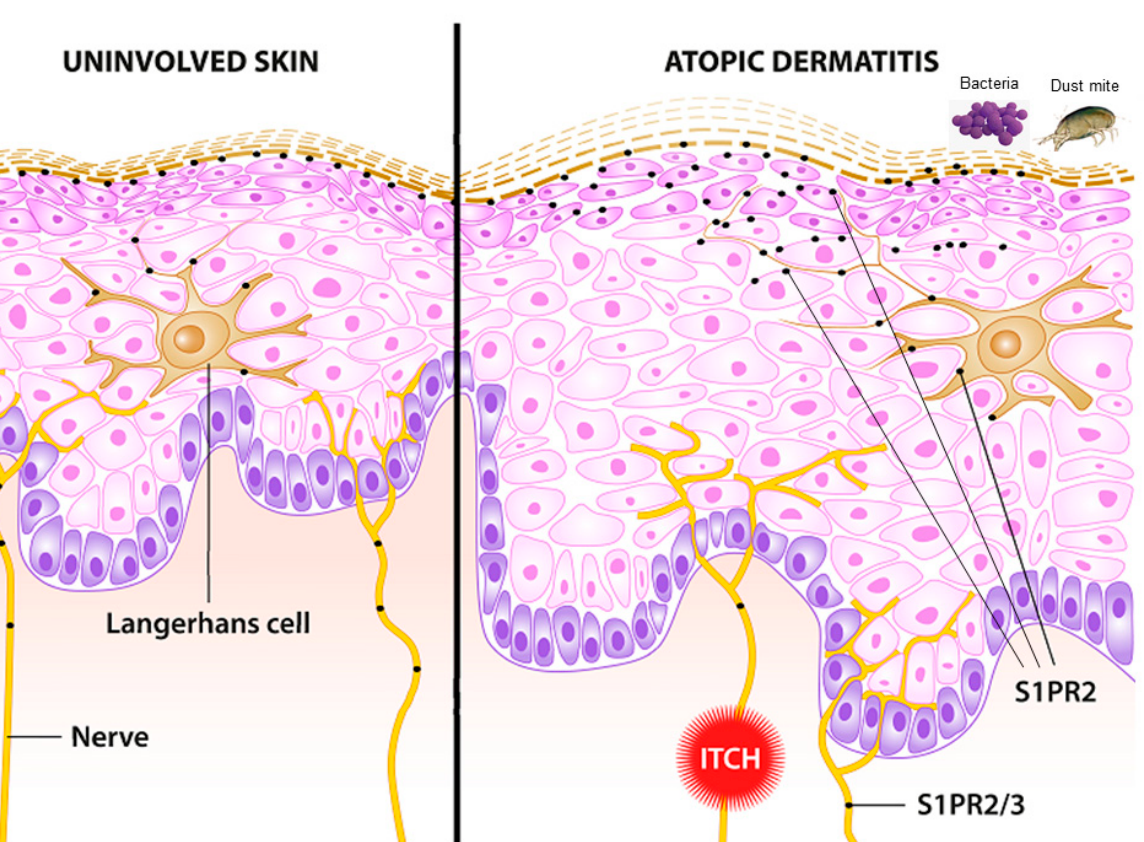
Figure 4. Schematic of uninvolved skin (left) and lesional skin in atopic dermatitis (right). S1PR2 and partially S1PR3 are involved in crucial pathways associated with atopic dermatitis. Lichenification and skin proliferation are under the control of S1PR2. Bacterial infection with S. aureus induces an alarmin function in keratinocytes mediated via S1PR2. Langerhans cells are pivotal antigen- presenting cells in the skin. The uptake of antigen and allergens is modulated via S1PR2. Itch, a pivotal symptom of atopic dermatitis, is partially mediated via S1PR2 and